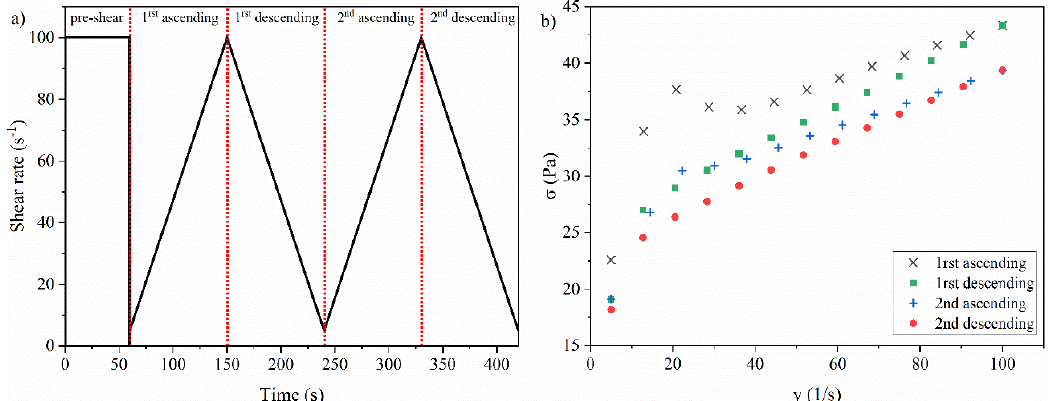
Figure 4. Shear process analyzed from the ascending and descending